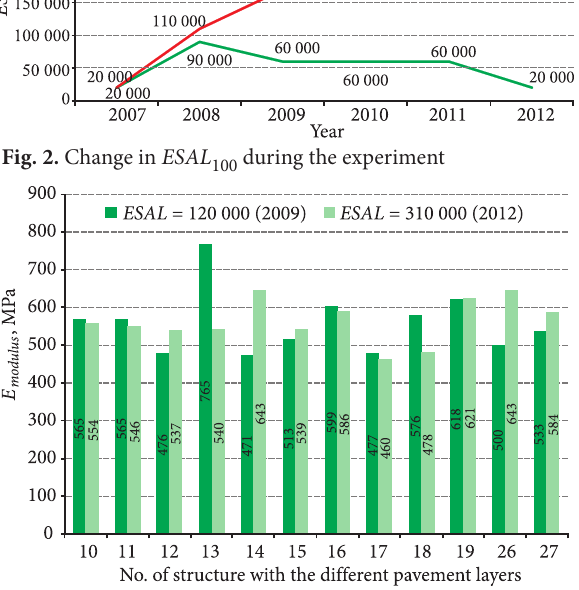
fig. 3. Change in the static modulus of elasticity in the rut of the loaded traffic lane